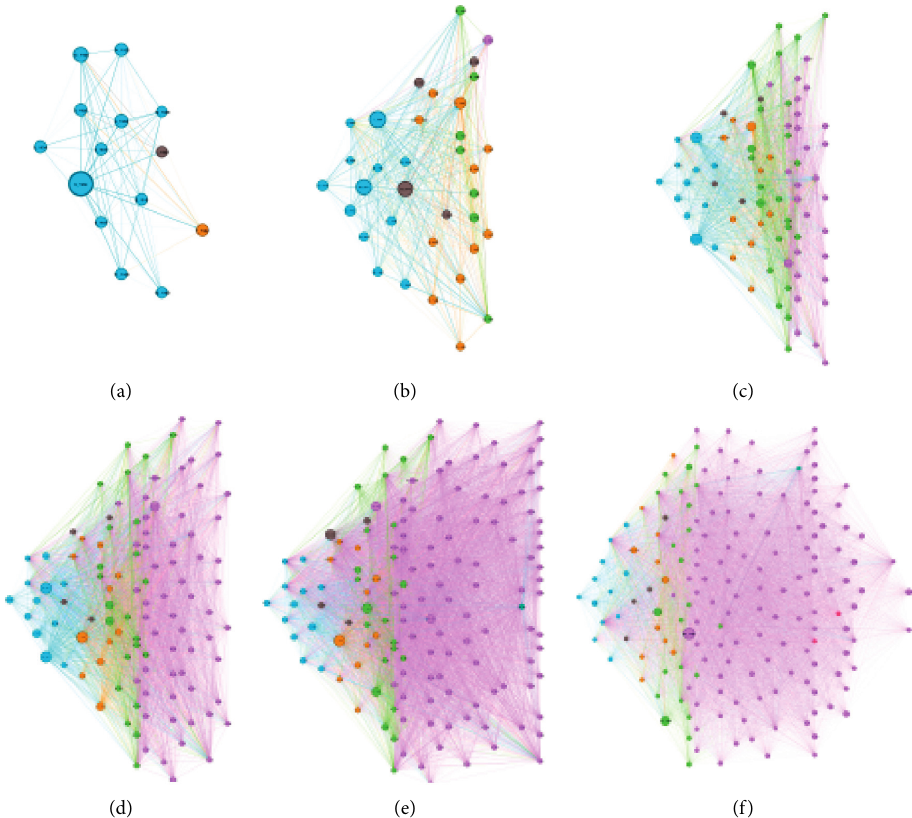
Figure 18: N network based on IR .166 paintings colored by artistic style (see Table 3). Creativity scores are represented by node size. We 3 5 split by consecutive periods of 6 years. (a) Subset of paintings from 1934 to 1940. (b) Subset of paintings from 1934 to 1946. (c) Subset of paintings from 1934 to 1952. (d) Subset of paintings from 1934 to 1958. (e) Subset of paintings from 1934 to 1964. (f) Subset of paintings from 1934 to 1976.